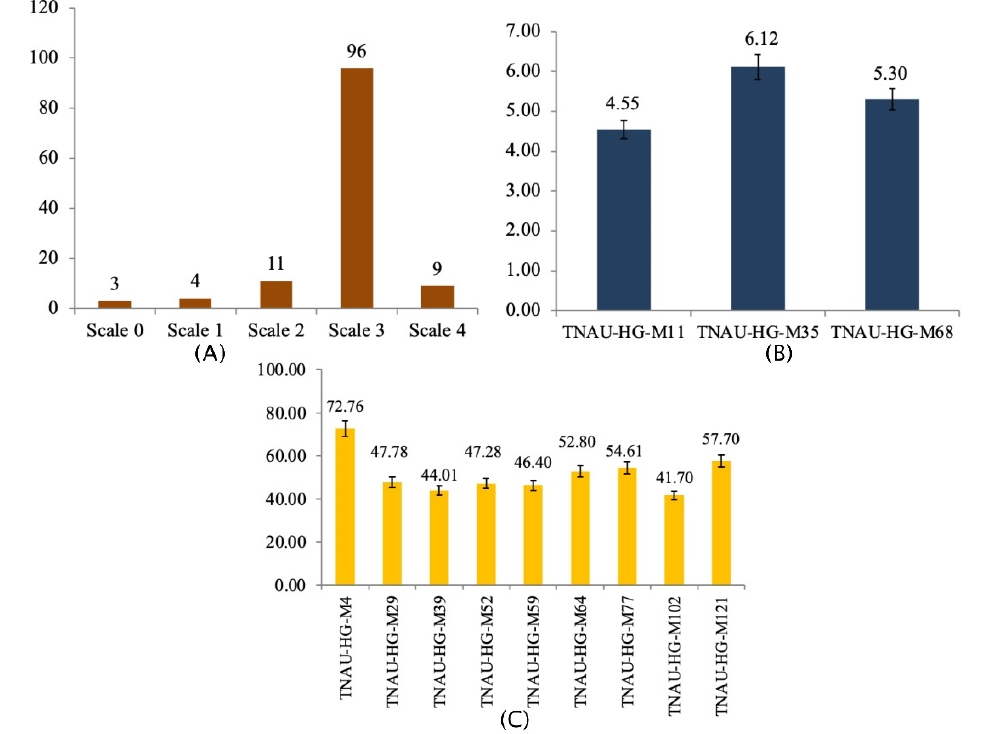
Figure 2. ( A ) Categorization of horse gram mutants for powdery mildew resistance; ( B ) Percentage of yield loss in the resistant mutants (Scale 4) due to E. polygoni infection; ( C ) Percentage of yield loss in the susceptible mutants (Scale 4) due to E. polygoni infection.